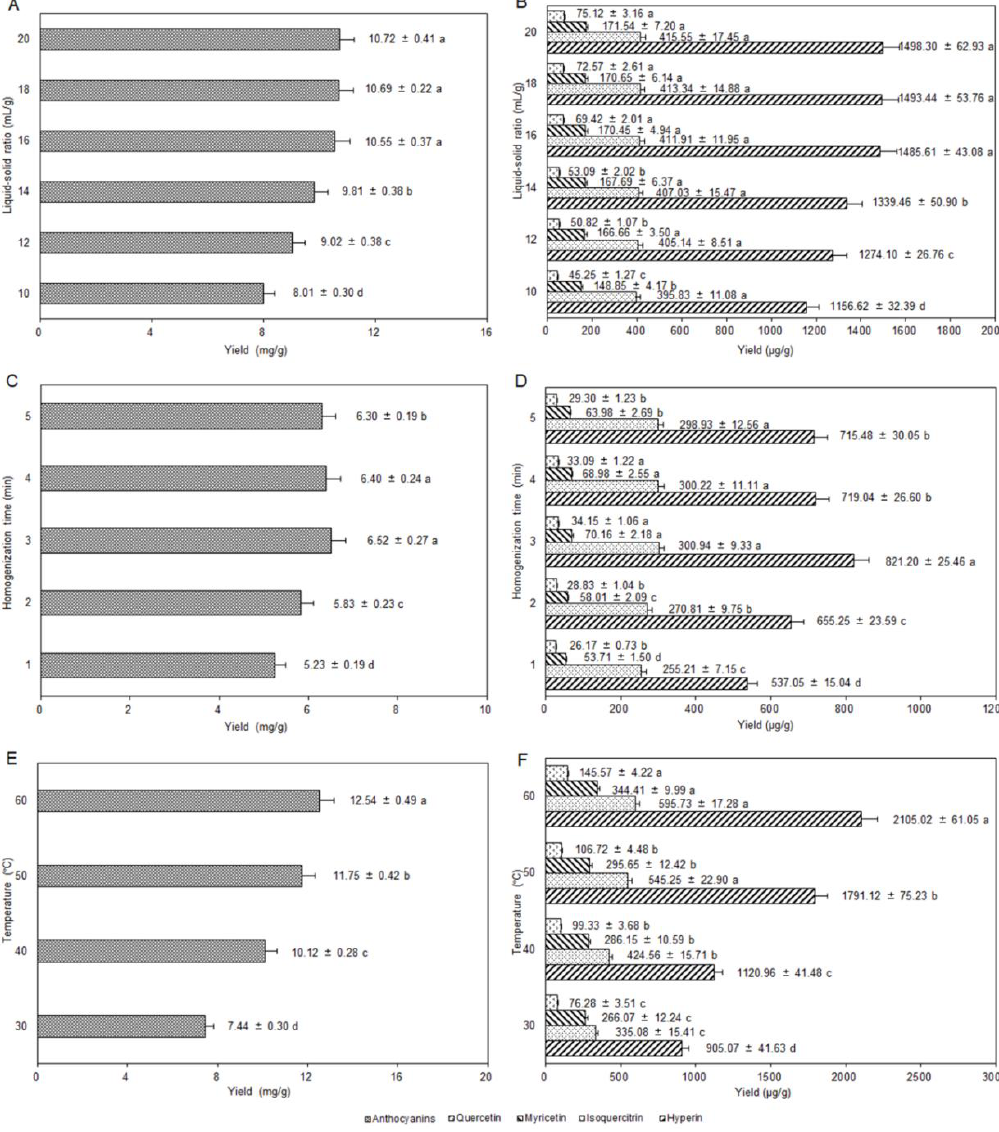
Figure 3. Influence of liquid–solid ratio on the extraction yields of anthocyanins ( A ) and flavonols ( B ); influence of homogenization time on the extraction yields of anthocyanins ( C ) and flavonols ( D ); influence of temperature on the extraction yields of anthocyanins ( E ) and flavonols ( F ).